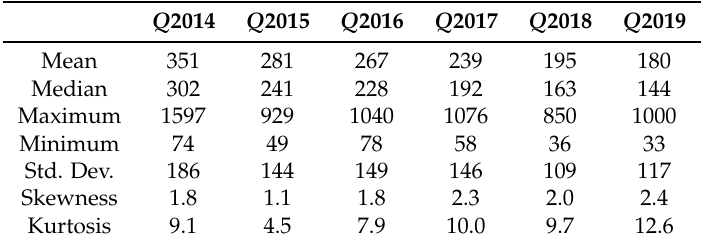
Figure 4. ( a ) The line graphs of the regional daily extreme values ( µ g/m 3 ) from 2014 to 2019 (Q2014 represents those extreme values in 2014 and so on; the same thereafter). ( b ) The boxplots of seasonal extreme values ( µ g/m 3 ) from 2014 to 2019. (2014Q1 represents the first season of 2014 and so on.) Table 1. Descriptive statistics of extreme values ( µ g/m 3 ) from 2014 to 2019.